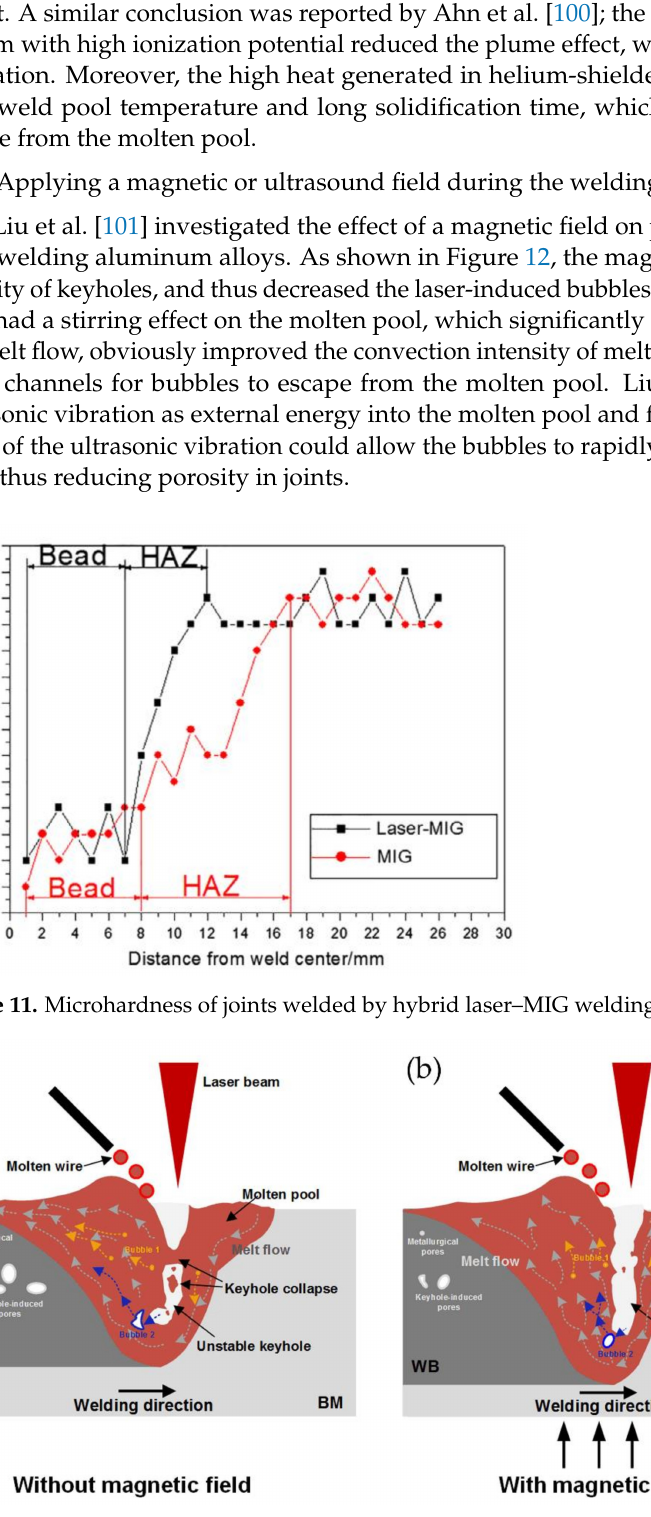
Figure 12. The schematic diagram illustrates the porosity formation and evolution under laser-MIG hybrid welding with and without a magnetic field [101]. ( a ) without magnetic field; ( b ) with magnetic